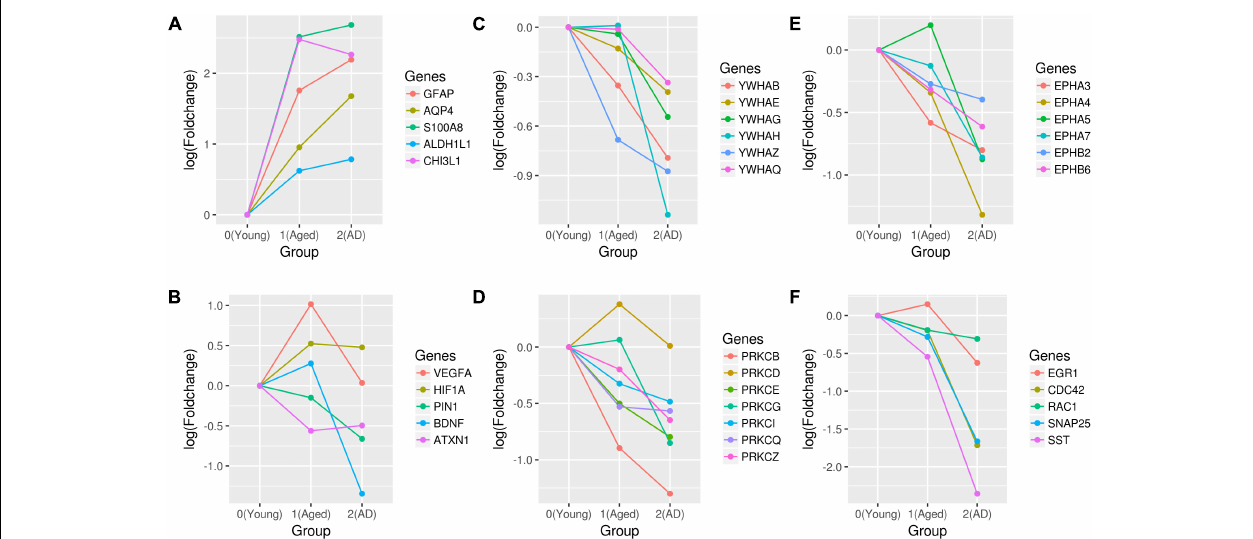
FIGURE 6 | Expression profiles of genes associated with aging and AD. The fold changes of (A) astrocytes markers, (B) neuroprotective genes (VEGFA, HIF1A, PIN1, BDNF, and ATXN1), (C) 14-3-3 proteins, (D) PRKC isoforms, (E) ephrin receptors, and (F) synapses and actin cytoskeleton genes (EGR1, CDC42, RAC1, SNAP25, and SST) are shown. Fold changes are calculated with respect to the expression of young